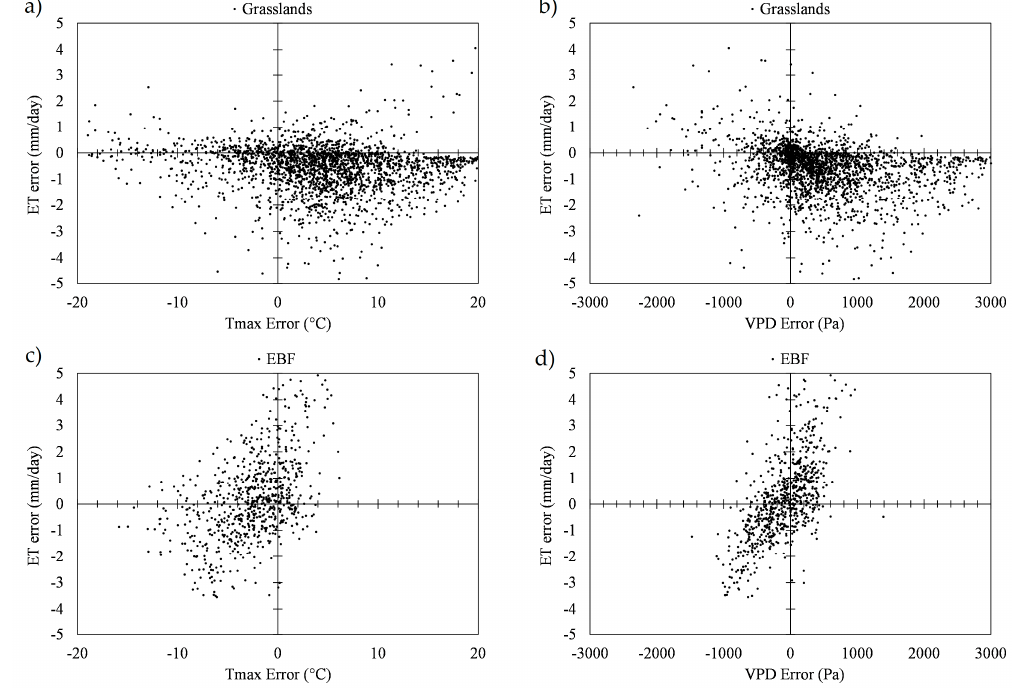
Figure 9. Days with different daily T max ( a , c ) and VPD ( b , d ) errors versus ET LST errors for grasslands (Grass) and Evergreen Broadleaf Forests (EBF) over the period of 2000–2006. Errors are daily estimates minus measurements.